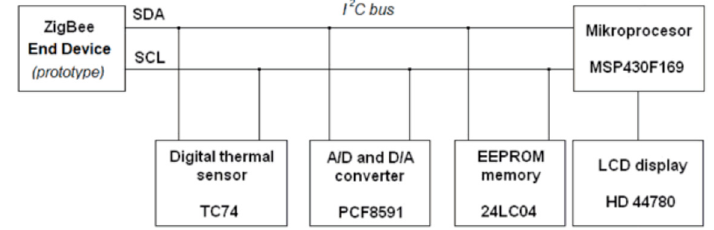
Figure 7. The autonomous microprocessor system cooperating with the ZigBee End Device.